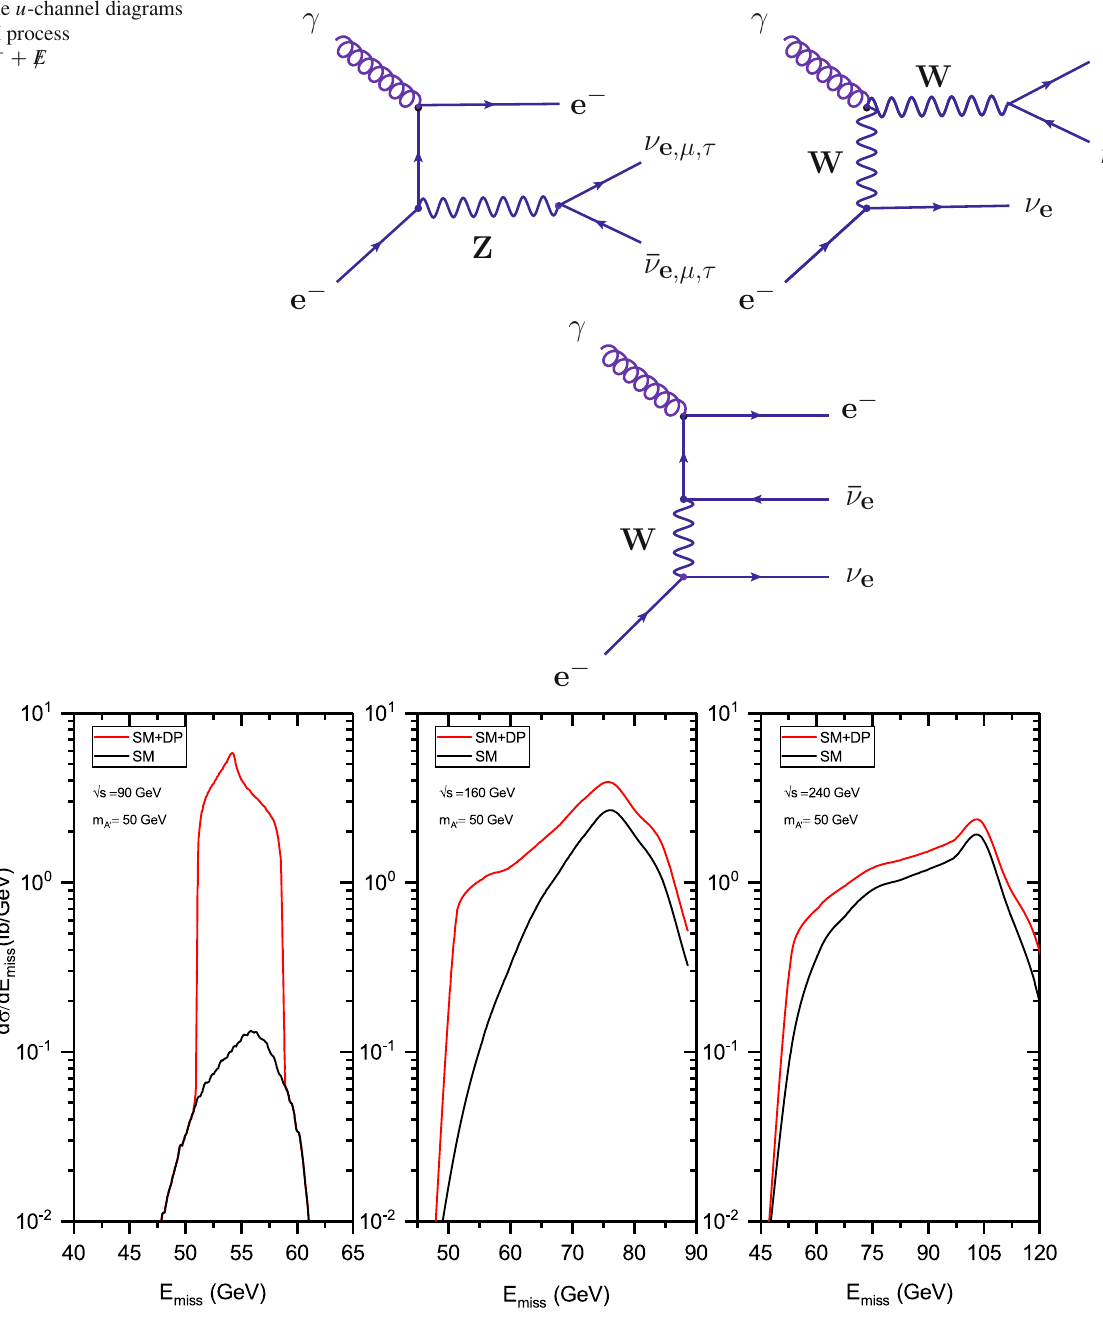
Fig. 5 The u -channel diagrams